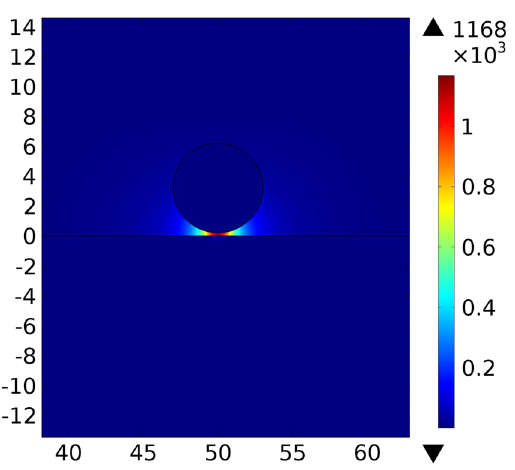
Figure 8. Simulated electric field [V/m] for a semi-insulating InP waveguide above the InP:Si substrate at = 32.56 µ m. Spatial dimensions are in µ m. λ 0